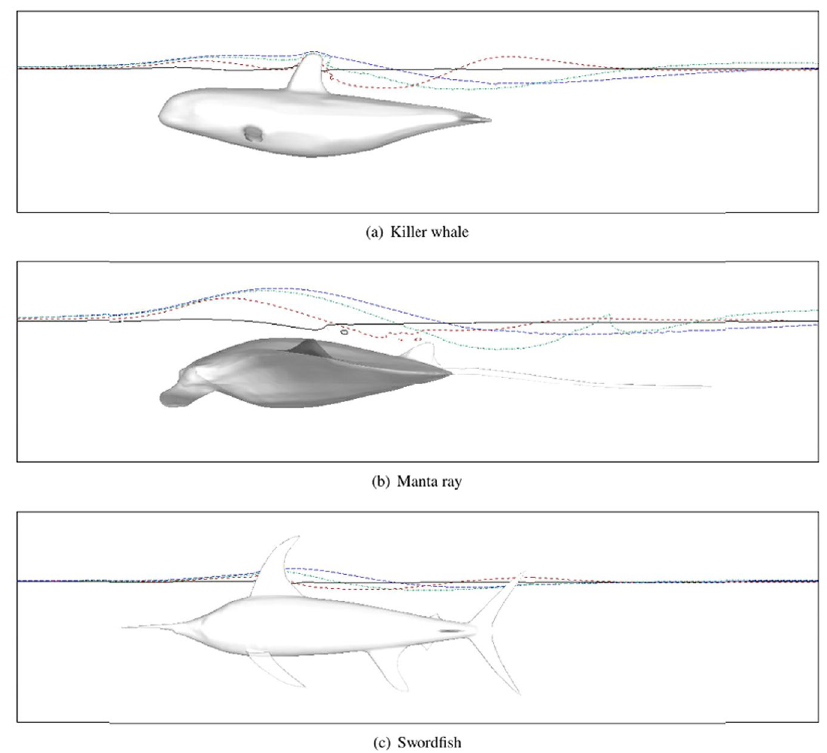
Figure 6. Instantaneous wave profile for various Froude numbers for Case NS at the beginning of the wave. The four lines are ordered from bottom to top with increasing swimming speed U = 0.5, 1.5, 2.5, and 3.5 m/s. The CAD models are created in Rhinoceros 17